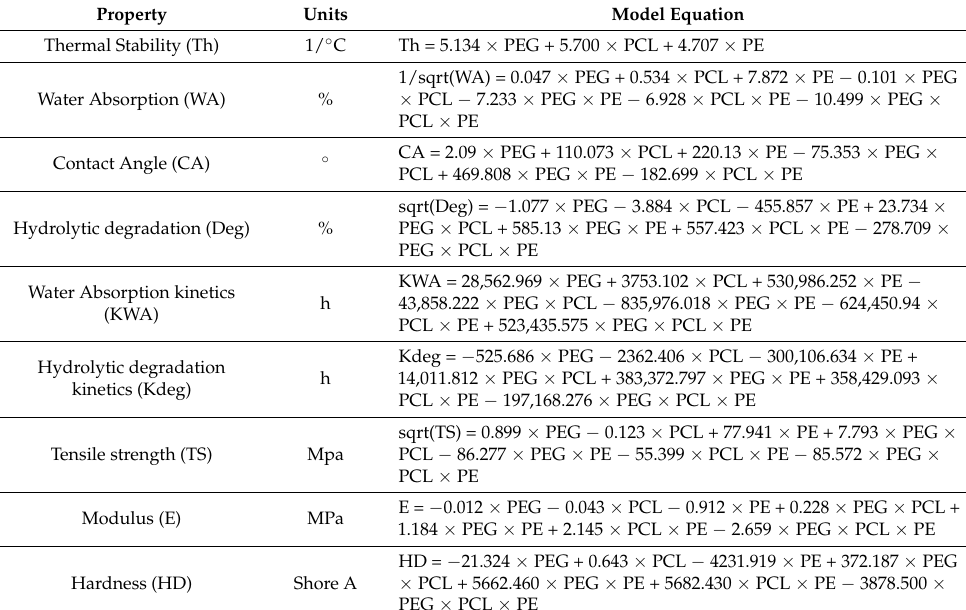
Table 1. Equations representing the models for the five properties